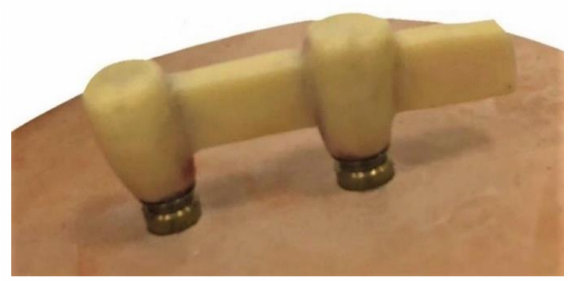
Figure 2. Wax pattern of the cantilever design